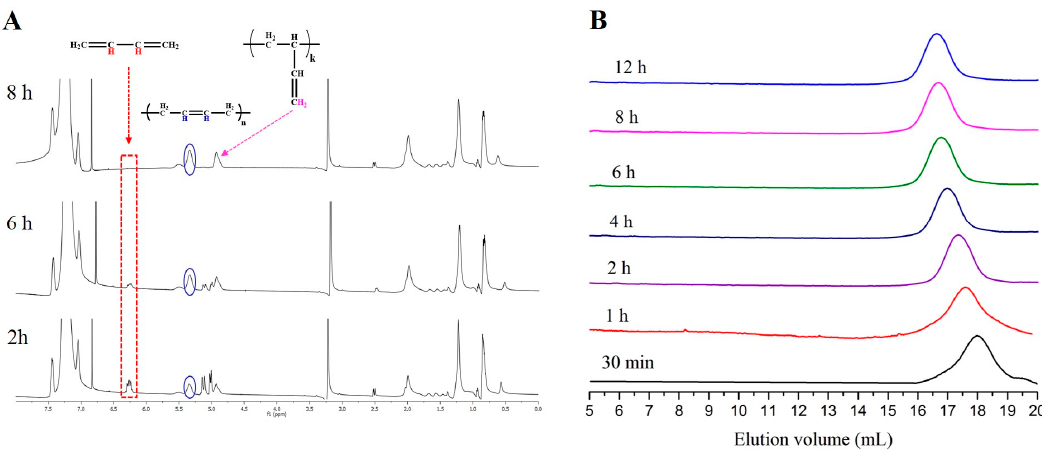
Figure 4. ( A ) 1 H-NMR spectrum after 2 h, 6 h and 8 h (100% conversion) {[ t -BuP 2 ]/[ sec -BuLi]:1/1, 1,3-butadiene}, indicating the different polybutadiene microstructures; ( B ) SEC traces obtained from withdrawn aliquots at different time intervals during the [ t -BuP 2 ]/[ sec -BuLi]:1/1 polymerization of butadiene.